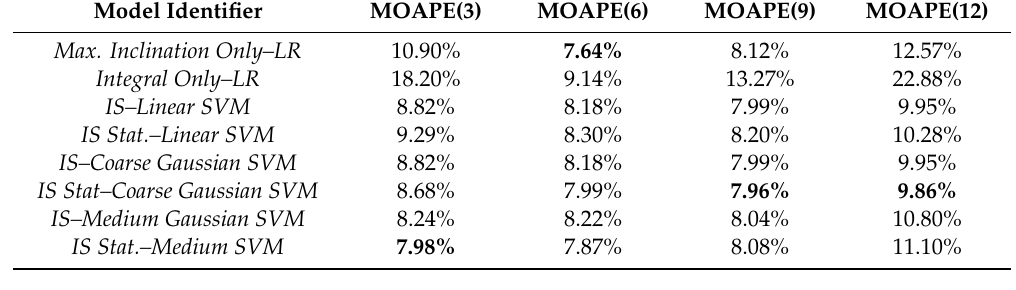
13 of 19 Figure 11. Distribution of the fill ratio mean absolute percentage error across trials for the best-case estimator. The fill ratio MOAPE is shown in Table 5 for varying drink sequence lengths. In contrast to volume estimation, the point nature of fill ratio estimates does not allow for sequential error cancelation across multiple drinks. Accuracy generally degrades with an increasing sequence length.